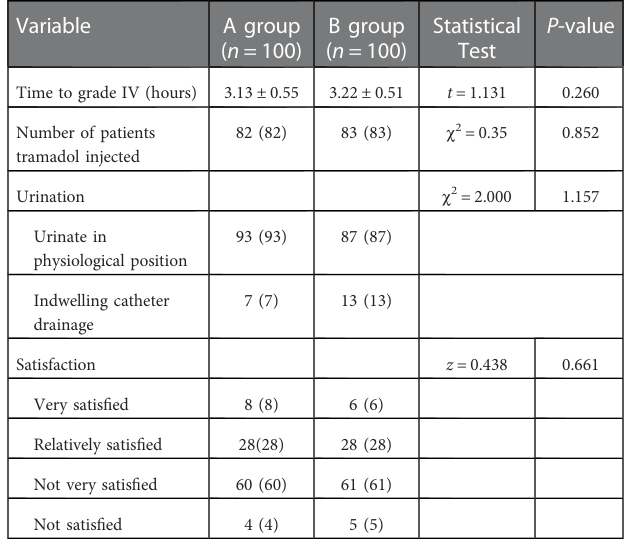
TABLE 3 Comparison of lower limb muscle strength recovery time, urination after anesthesia and satisfaction at 48 h after anesthesia. Variable